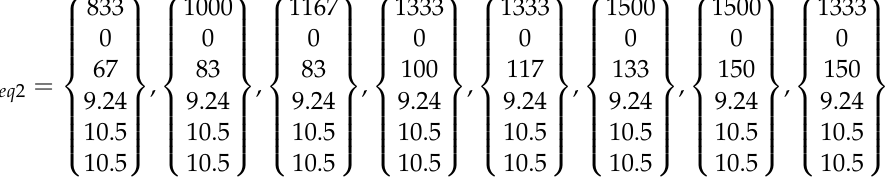
Table 4. Modified flowrate and RPM thresholds for varying the action-space. Control Variable Number of Discrete Values Range of Values